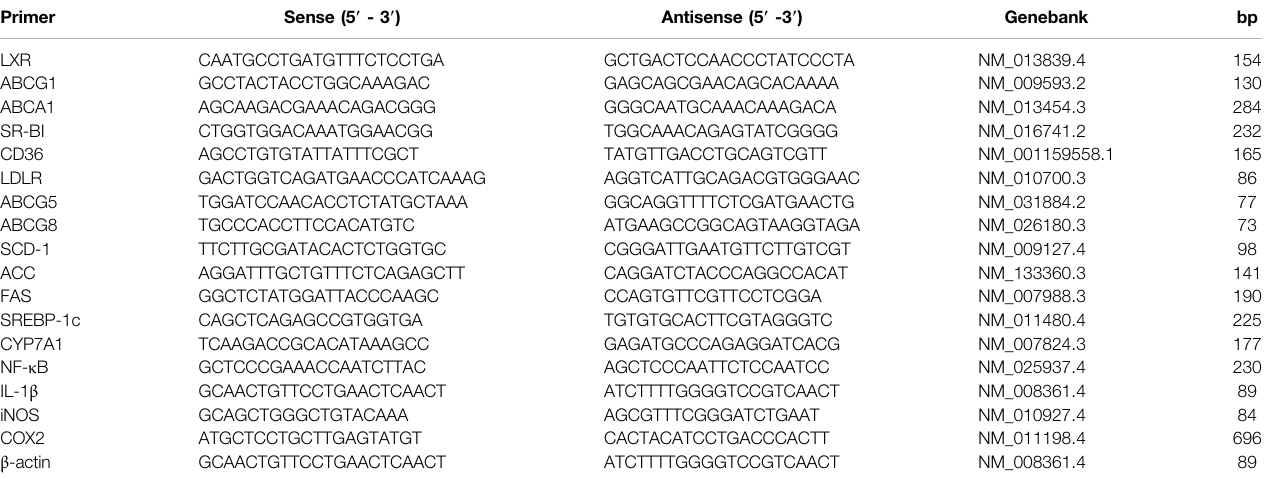
TABLE 1 | Ampli fi ed gene